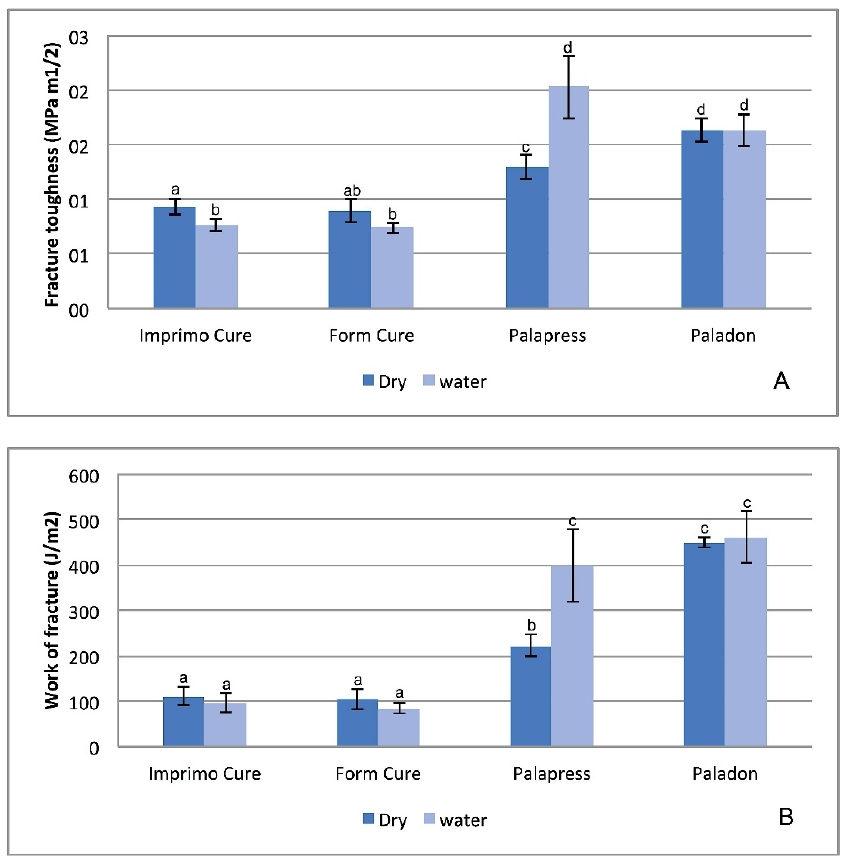
Figure 2. Diagram of fracture toughness ( K Ic ) and fracture work (W f ) mean values for tested groups. Same superscripted lowercase letters show groups/subgroups not statistically significantly different when compared by Dunnett’s T3 post hoc analysis ( p > 0.05).